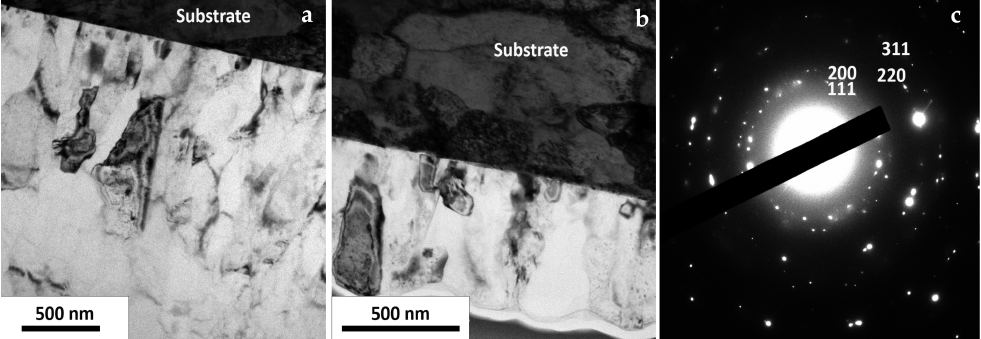
Figure 7. ( a , b ) Bright-field TEM images of samples E52 and E46, respectively, with different thickness of the as-grown Al layer. The Ni substrate is marked. Dark dots in the Al layer are originated from Ga irradiation during sample preparation in the FIB. ( c ) A typical SAED pattern taken from the Al layer on sample E52. This polycrystalline pattern is indexed according to the Al structure ( Fm 3 m , a = 4.04